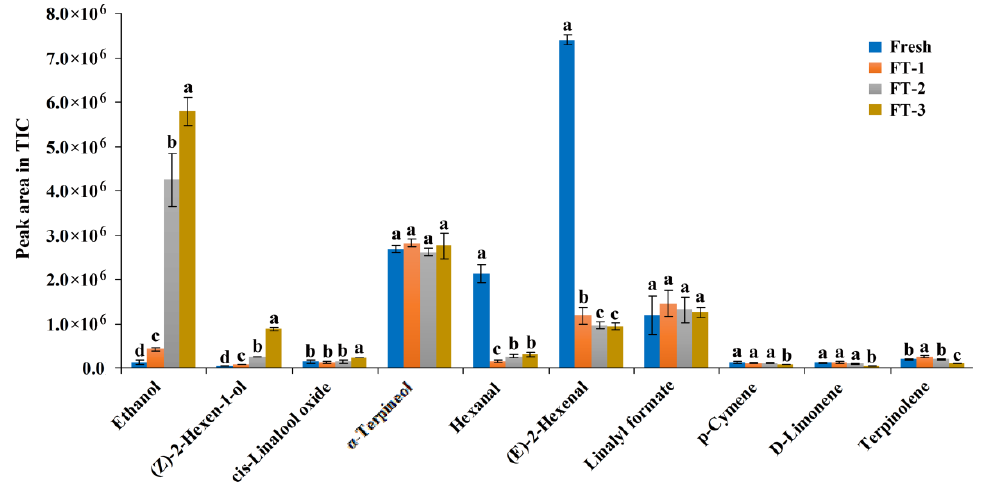
Figure 4. The peak area in total ion chromatogram (TIC) assigned to 10 main compounds for freeze-thaw (FT) treated samples. FT-1, FT-2 and FT-3 represent the sample with FT treatment once, twice and third times. Values are presented as mean ± standard deviation ( n = 2). Different letters indicate significant differences ( p < 0.05).